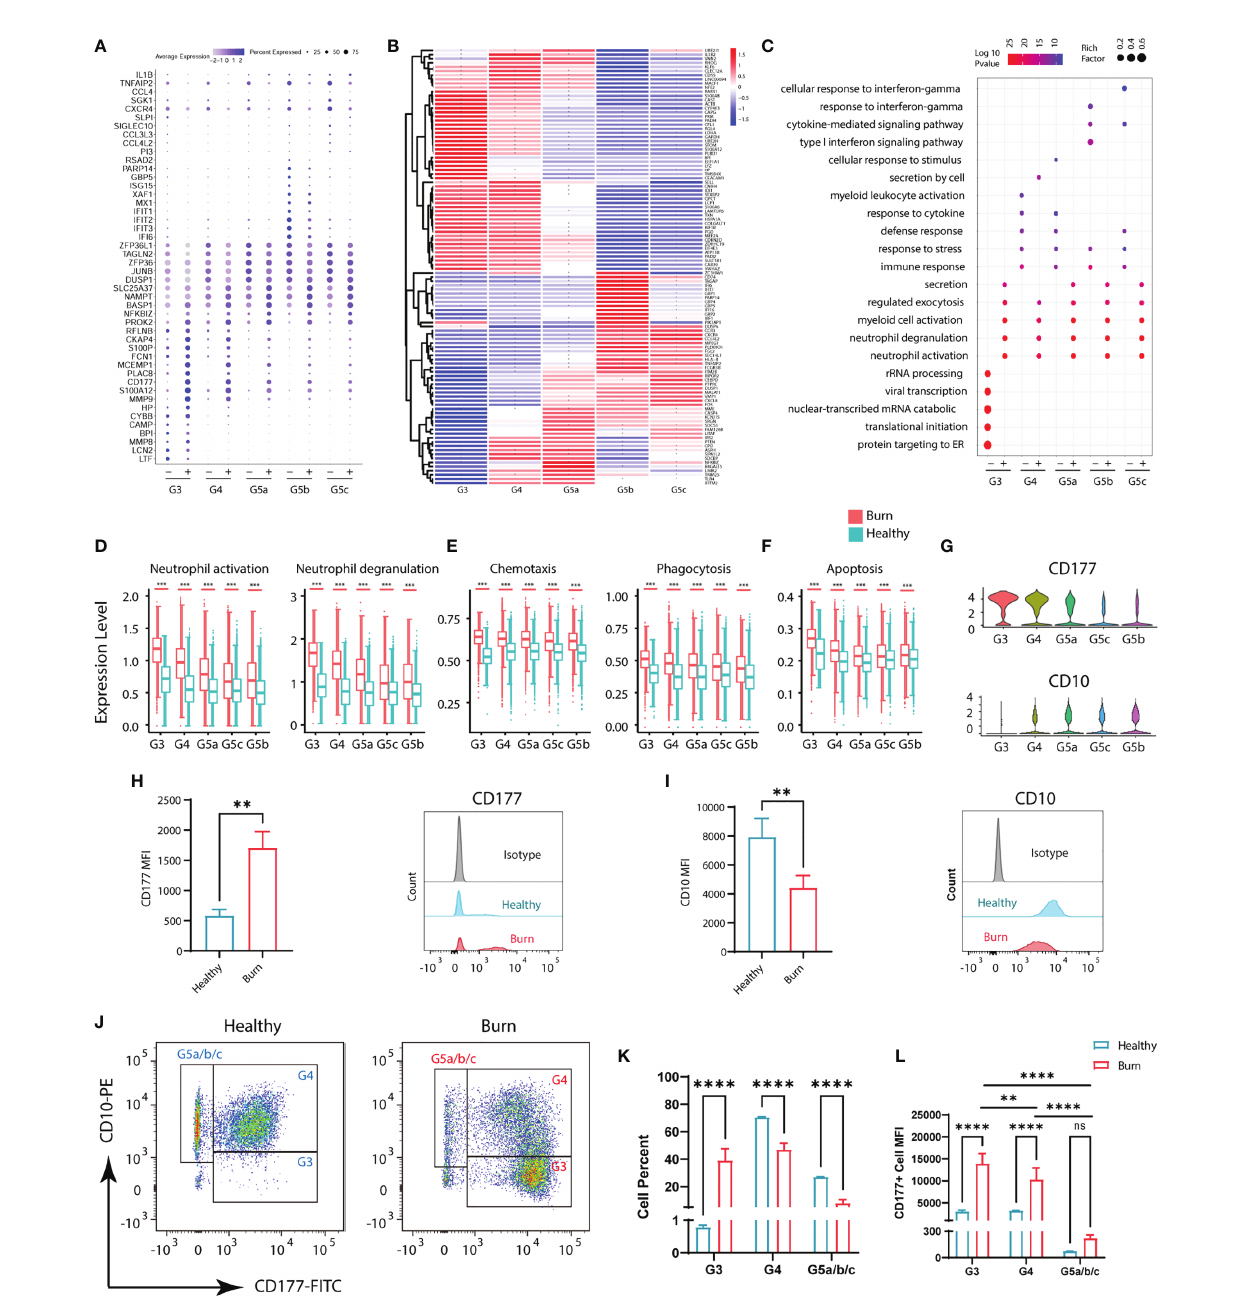
FIGURE 3 | Functional changes of PMNs in healthy controls and severe burn injuries. (A) Conserved genetic tags of neutrophil subsets. (B) Heatmap of differential genes in subsets of PMNs in healthy controls and severely burn injuries. The asterisks represent differences in gene expression between burn injuries and healthy subjects. (C) GO (BP) analysis of neutrophil subsets in healthy controls or severe burn injuries. (D – F) Functional scores of each subgroup of PMNs. Neutrophil activation and neutrophil degranulation (D) , chemotaxis and phagocytosis (E) , apoptosis (F) . (G) Violin diagram of genes CD177 and CD10 in 5 subgroups. (H – J) The expression levels of CD177 and CD10 in circulating PMNs of healthy controls and early stages of severe burn injuries., Separation of G3, G4 and G5a/b/c PMNs by fl ow cytometry. FACS and staining strategy for G3 (CD10 low -CD177 hi ), G4 (CD10 hi -CD177 mid ) and G5a/b/c (CD10 hi -CD177 low ) PMNs. (K) The proportion of each cell subgroup in the peripheral blood of healthy persons and burned patients. (L) Mean fl uorescence intensity of CD177 expression on G3, G4,G5a/b/c subsets of PMNs in peripheral blood of healthy and burned patients. Data represent means±s.d. (n=3 – 8) of two independent experiments. **p < 0.01, ***p < 0.001, ****p < 0.0001, ns, not